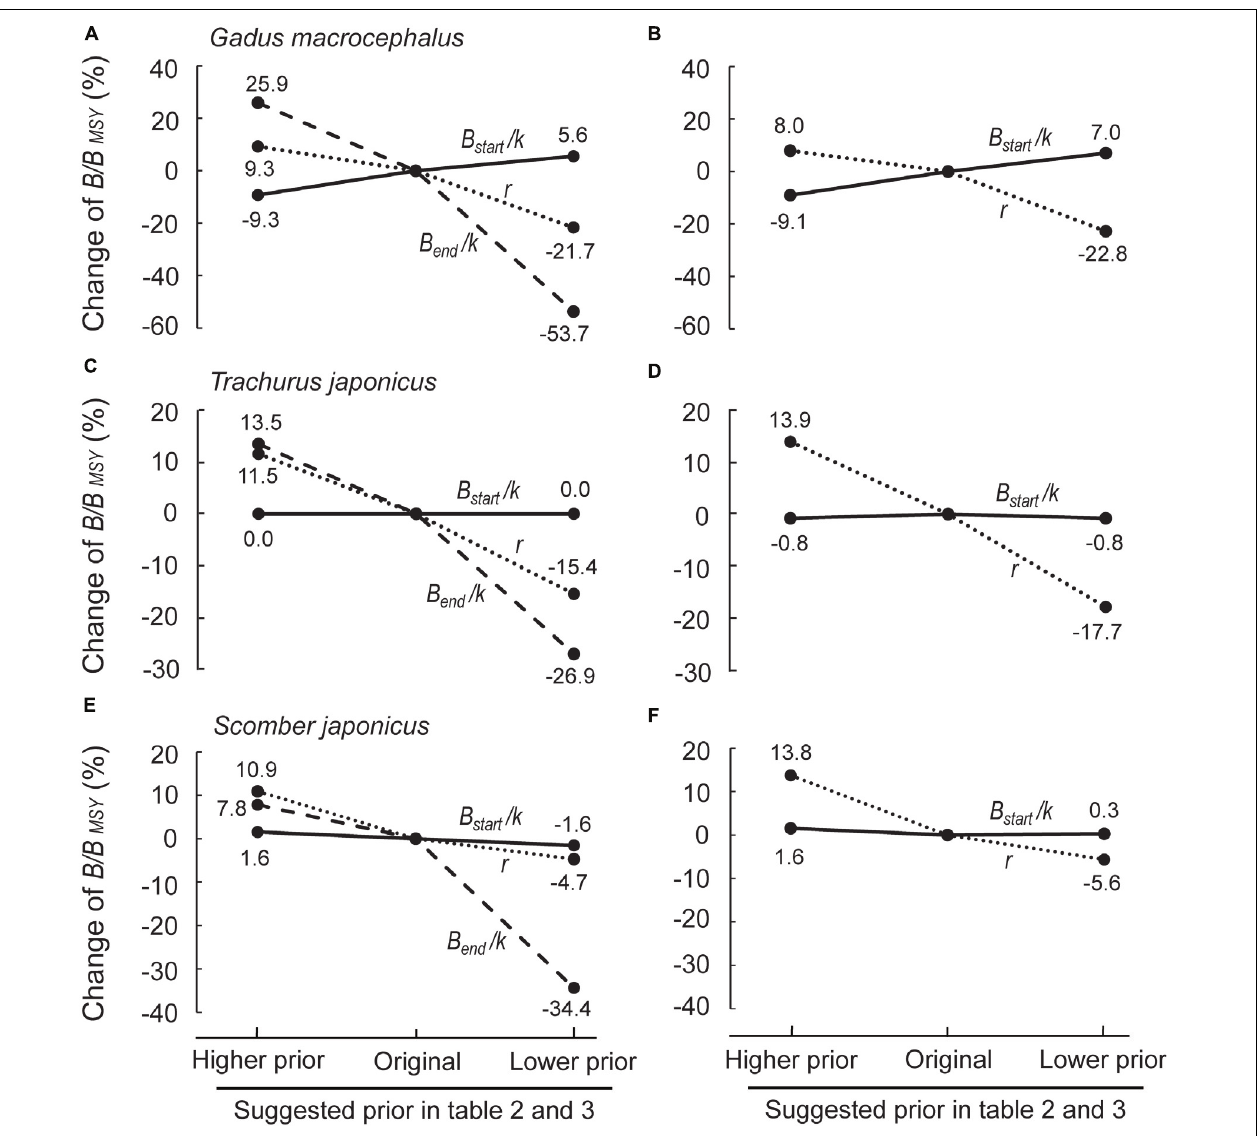
FIGURE 6 | Sensitivity of B/B MSY to changes of the priors ( r , B start /k and B end /k ) in Pacific cod ( Gadus macrocephalus ), Japanese jack mackerel ( Trachurus japonicus ) and chub mackerel ( Scomber japonicus ). (A,C,E) Effects of changing any of the 3 prior ranges ( r , B start /k and B end /k ); (B,D,F) effect of changing r and B start /k , while setting B end /k as “Not Available”; this produces virtually the same results as in (A,C,E) (see